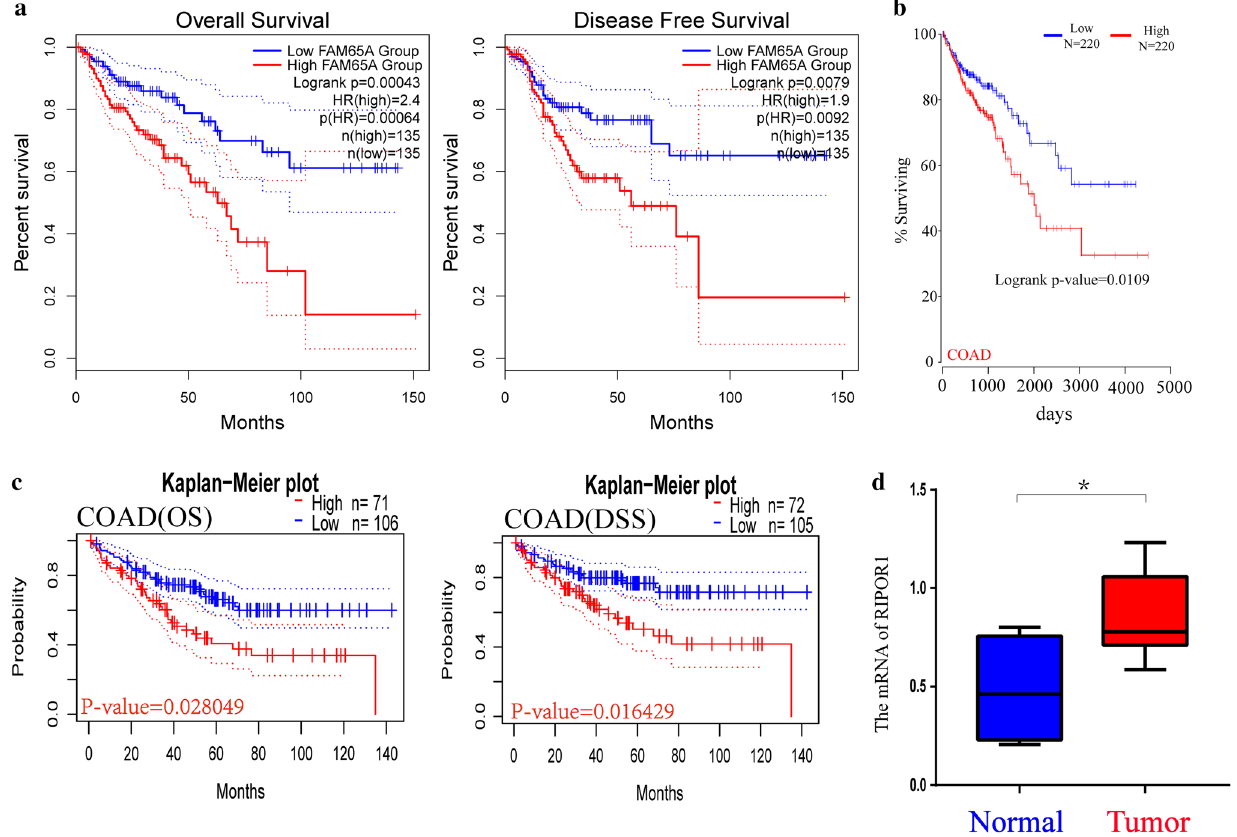
Fig. 2 Relationship between FAM65A gene expression and the prognostic values in colorectal cancer. a The FAM65A prognostic values were obtained through the GEPIA2 tool. b The FAM65A prognostic value was obtained through the Oncolnc. c The FAM65A prognostic values were obtained based on the GSE17536 cohort. d